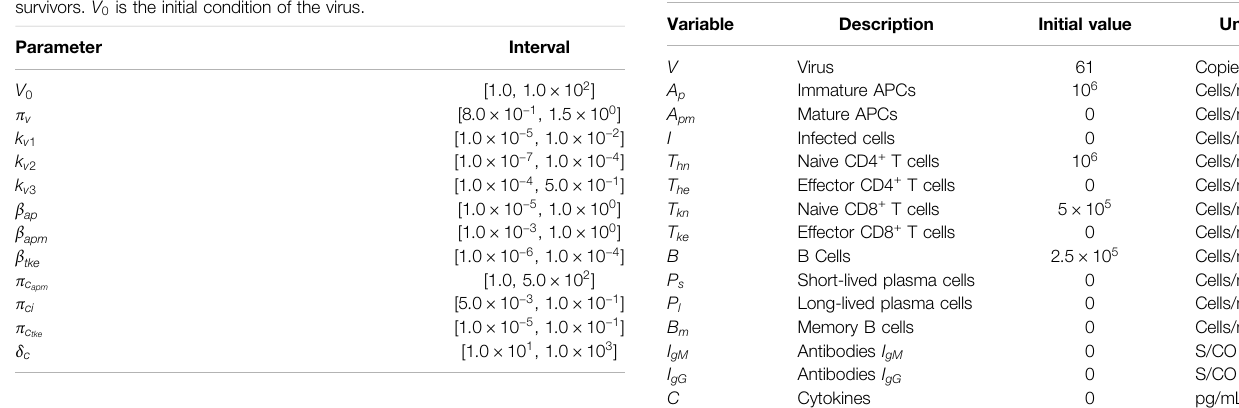
TABLE 4 | Model variables and their initial values.